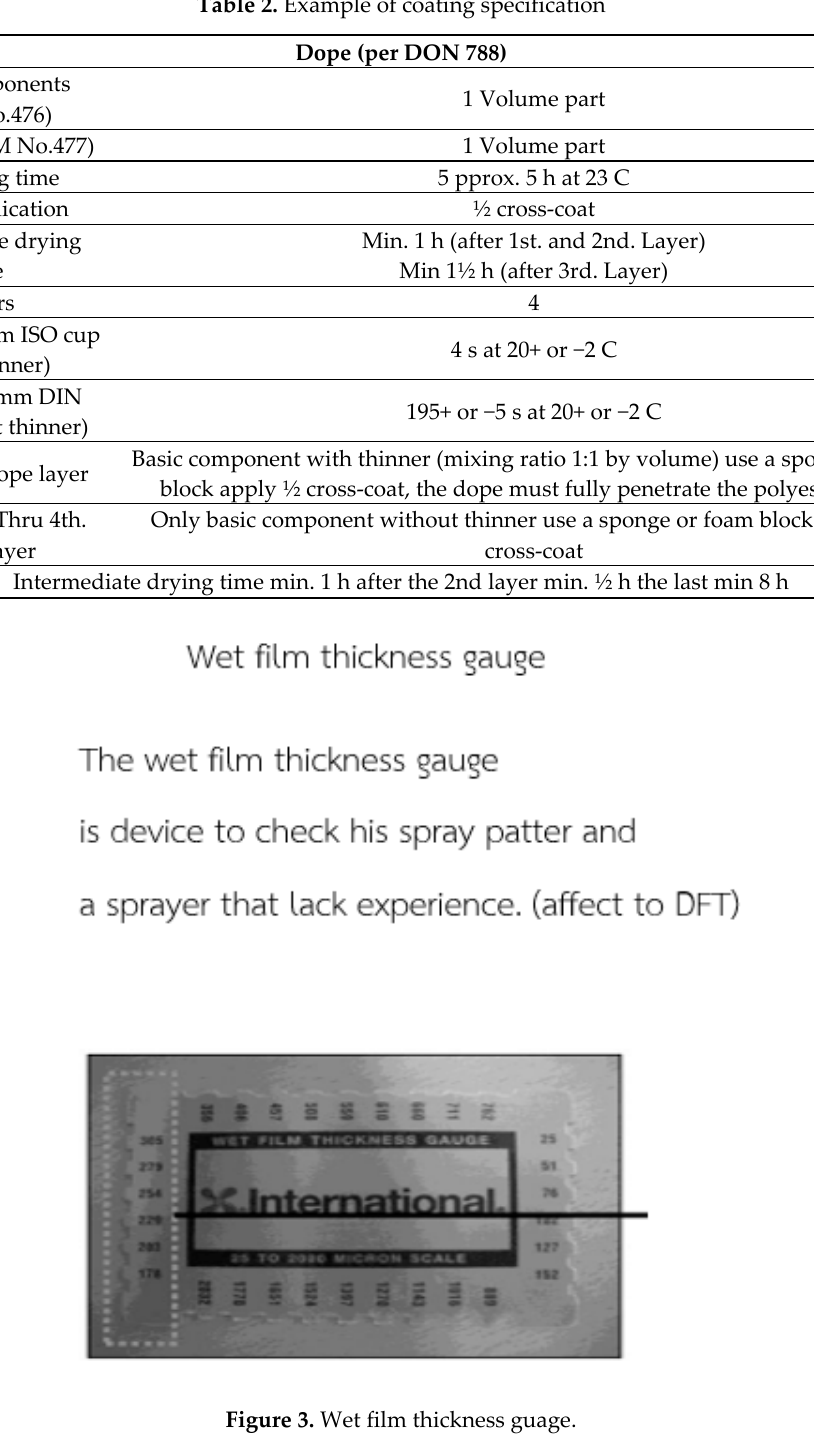
Figure 3. Wet film thickness